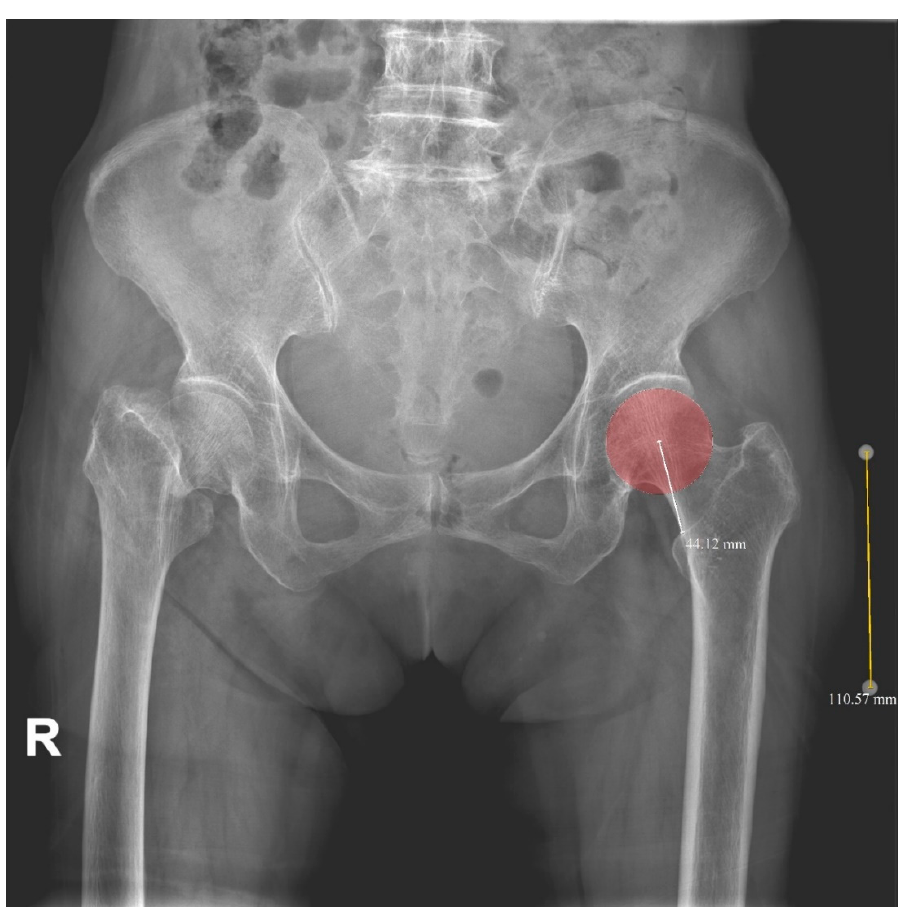
Figure 4. Two-dimensional head-lesser trochanter distance (2-D HLD). Magnification was corrected through a 10-cm sized magnification marker. R: right-sided on radiographs.